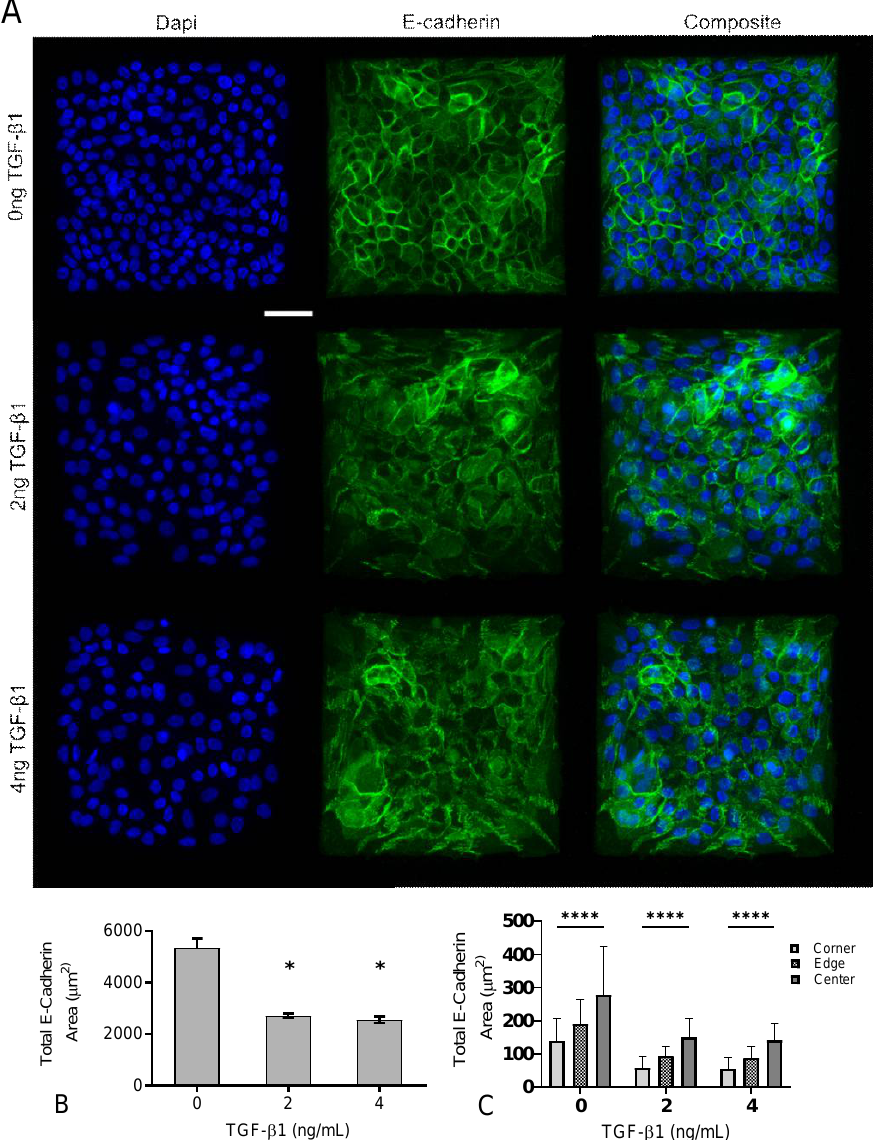
Figure 6. Increasing TGF- β 1 concentration disrupts adherens junctions in MCF10A square islands. ( A ) Representative immunofluorescence images of MCF10A cells cultured for 48 h with increasing concentrations of TGF- β 1. Ab staining for nuclei (blue), and E-cadherin (green). Scale bar 50 mm. ( B ) Total E-Cadherin area in immunofluorescence images. ( C ) Scale bar 50 µ m. n.s., not significant, * p ≤ 0.05 significantly different from control, **** p ≤ 0.05 significantly different from both edge and center within given concentration. p -values based on Bonferroni’s post-hoc multiple comparisons test following Two-way